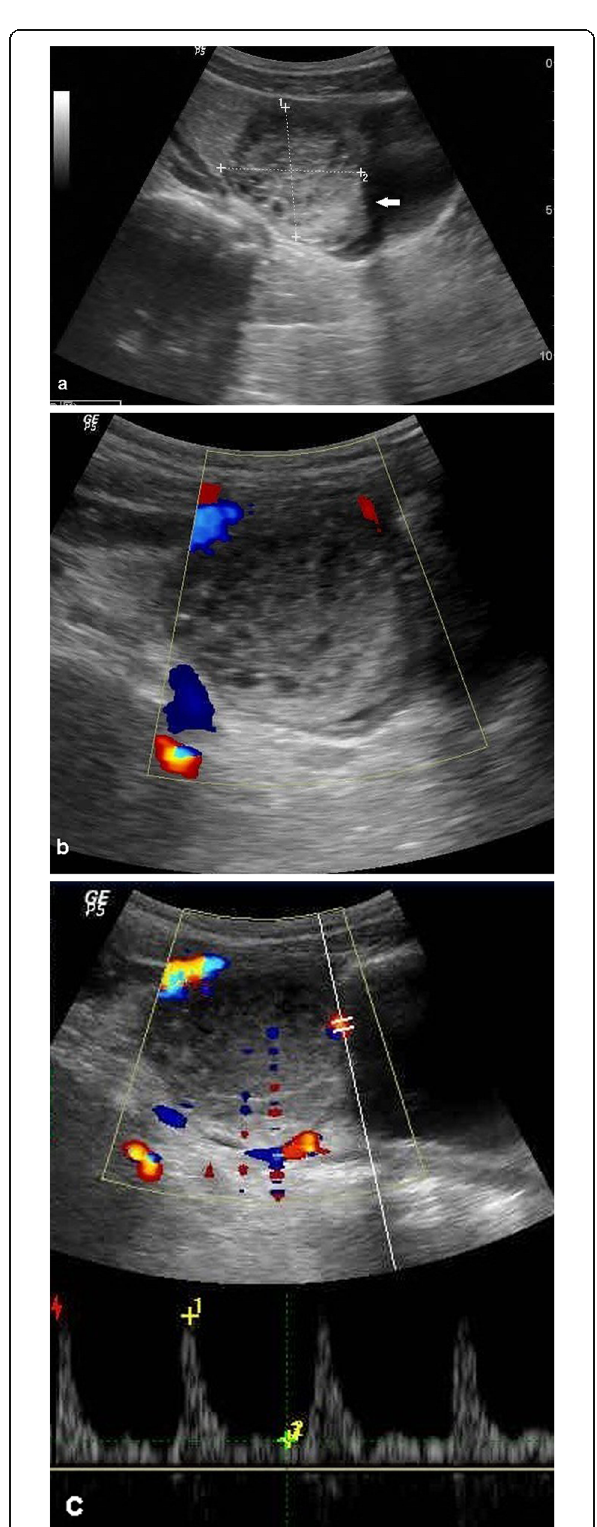
Fig. 1 A 27-year-old woman presented with intermittent lower abdominal pain. a Transabdominal ultrasound demonstrating a cystic lesion that has a solid-appearing area with a concave margin (arrow) due to retractile clot, and this area demonstrate a reticular lace like pattern due to fibrin strands. b Doppler ultrasound shows faint peripheral flow with no central flow within the lesion with spectral Doppler on the detected peripheral vessel; the RI was 0.7 and PI was 1.4. After 6 weeks of sonographic follow-up, there was a complete resolution of this lesion and it was characteristic